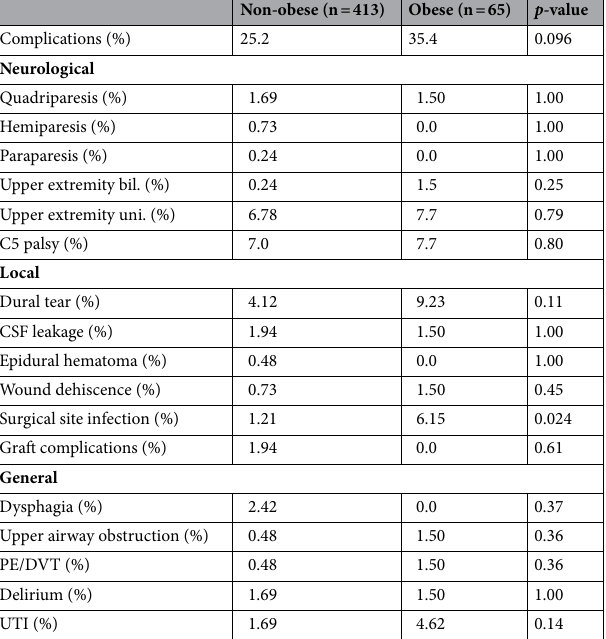
Anterior (n = 97) Posterior (n = 369) Non-obese (n = 82) Obese (n = 15) p -value Non-obese (n = 323) Obese (n = 46) p